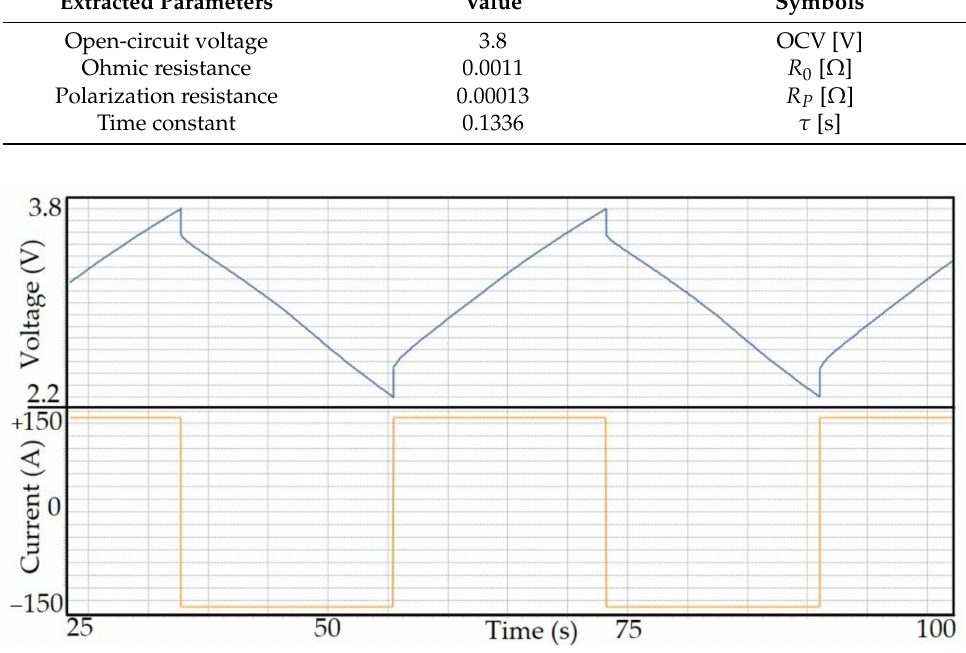
Figure 2. A segment of the applied current and voltage ( up ), and power loss of the LiC under fast charge/discharge with continuous 150 A current rate during 1400 s experimental test ( down